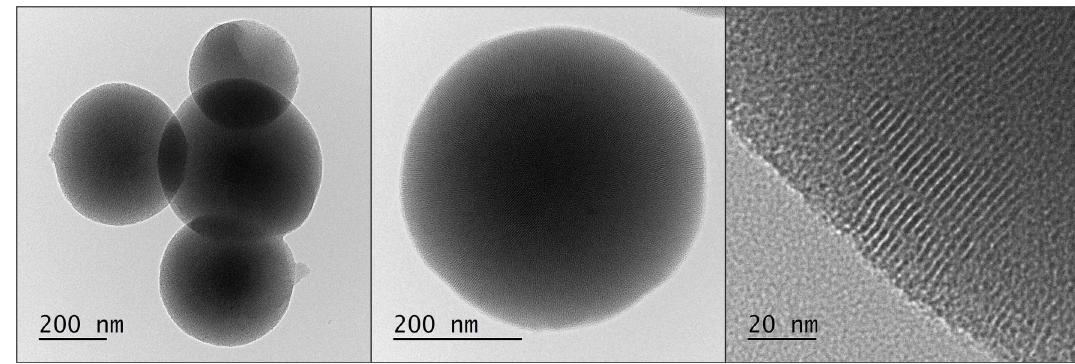
Figure 8. TEM micrographs of MCM-41 silica.